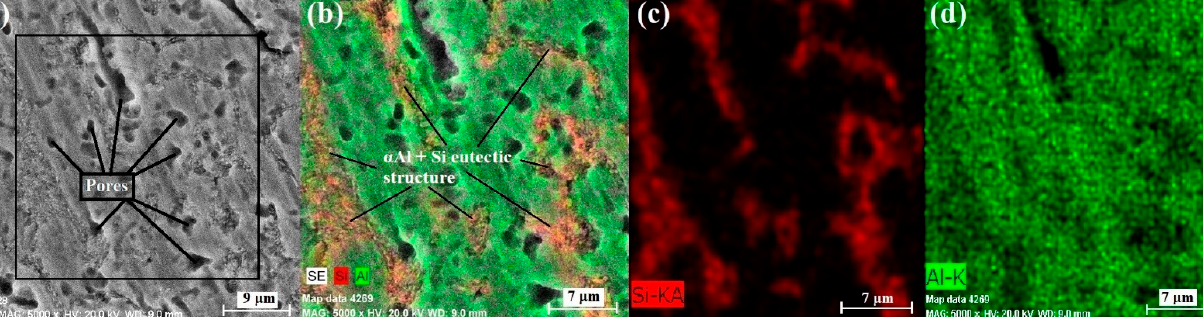
Figure 10. Vickers hardness of the samples taken from both specimens. 4. Discussion